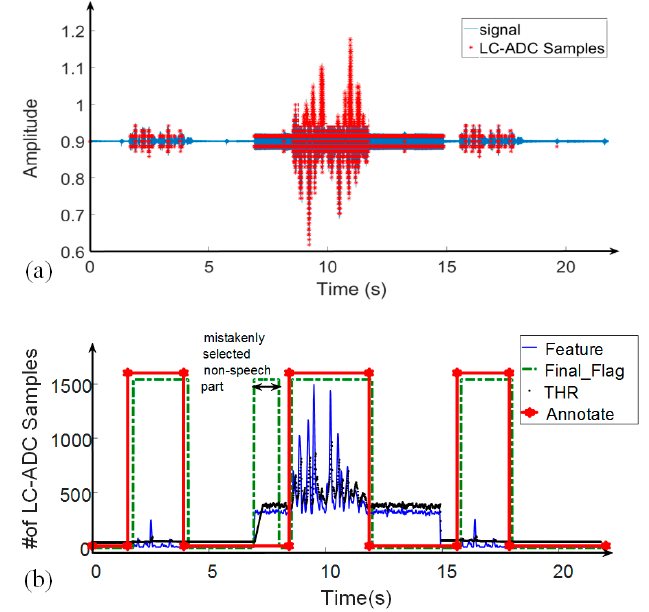
Figure 14. Three audio signals, all impregnated with white noise with significant amplitude differ- ences and different SNRs, were placed consecutively. The first and third audio signals are low-am- plitude, and the middle audio signal is high-amplitude with SNRs of 10, 0, and 5 dB, respectively. ( a ) Three audio signals and LC-ADC samples. ( b ) Feature signal, Final_Flag, THR, and Annotate signals.